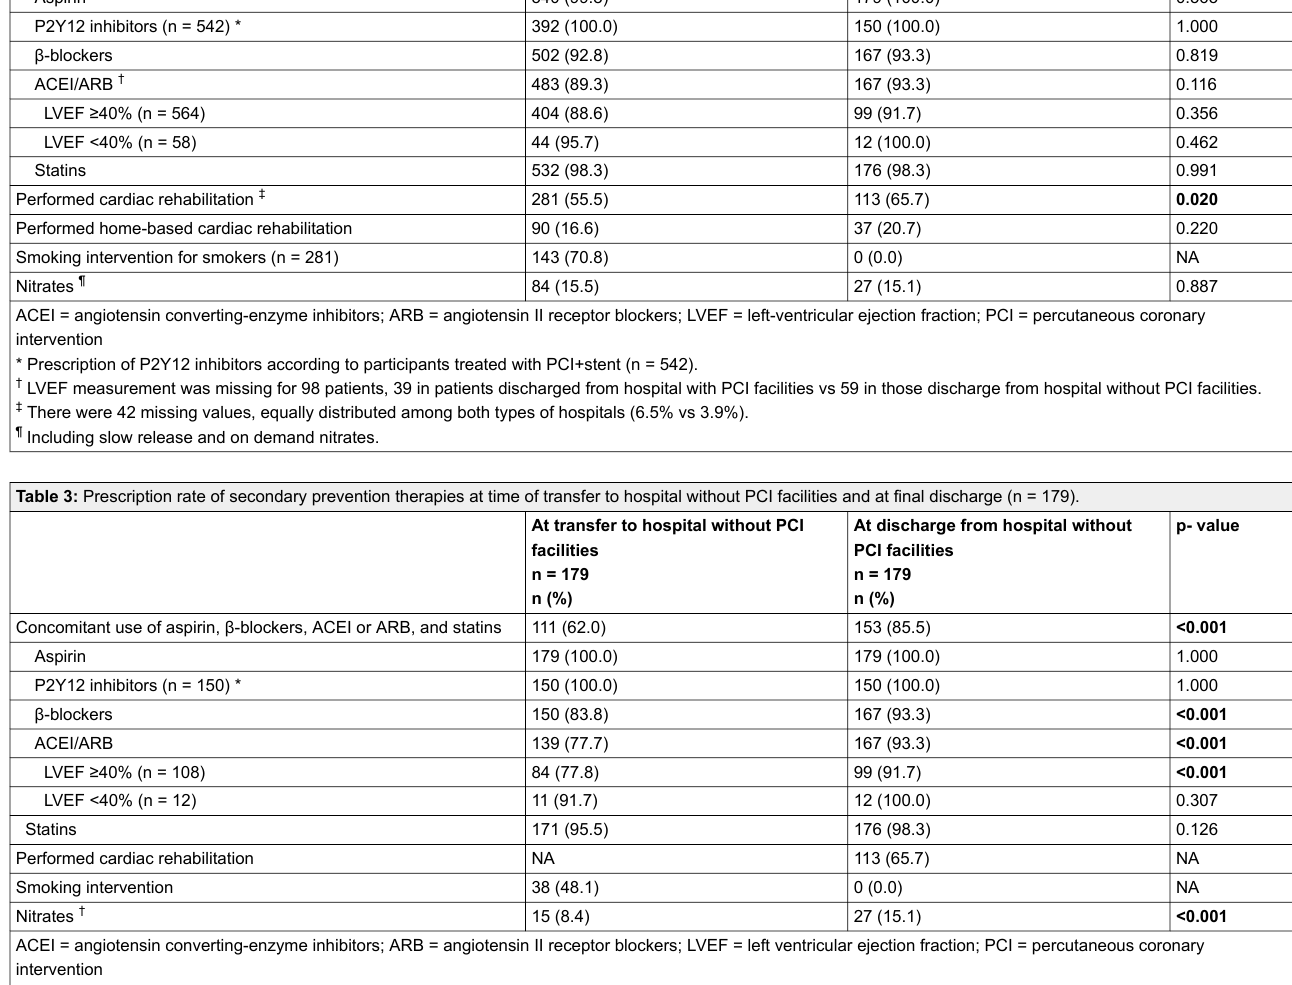
Hospital with PCI facilities n = 541